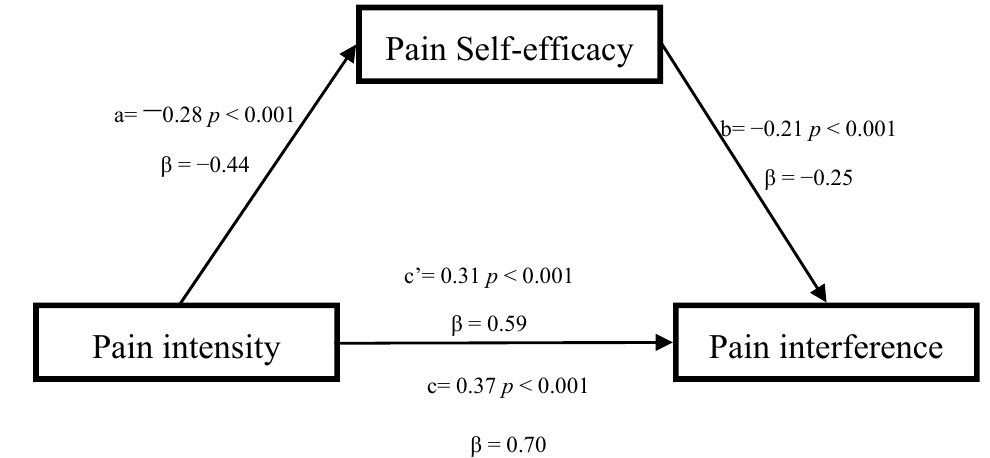
Figure 1. Linear regression results for the mediation model, adjusted by age and gender, with pain self-efficacy as the mediator between pain intensity and pain interference.